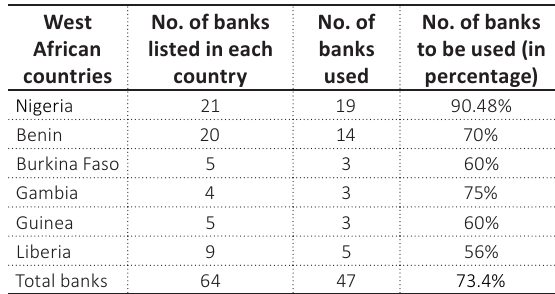
Table 2. Population and sample of banks used